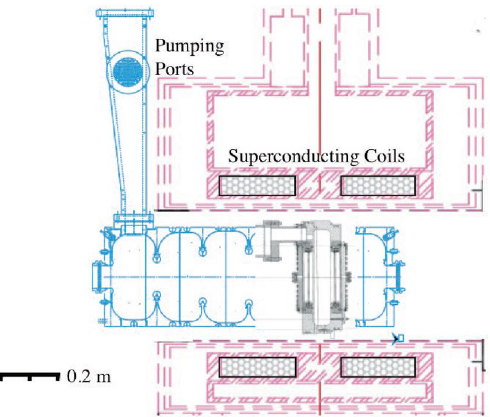
Figure 2. The six cell 805 MHz cavity (blue) in the superconducting magnet, showing the position of the single cell pillbox cavity with removable surfaces (gray) that replaced it 9 .